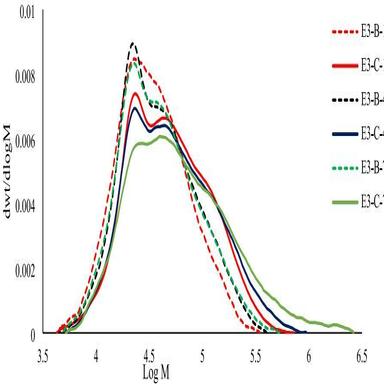
Evolution of normalized molecular weight distributions of E3 product mixtures synthesized using Process B (dotted lines) and Process C (solid lines) after 1, 4, and 7 days of reaction.